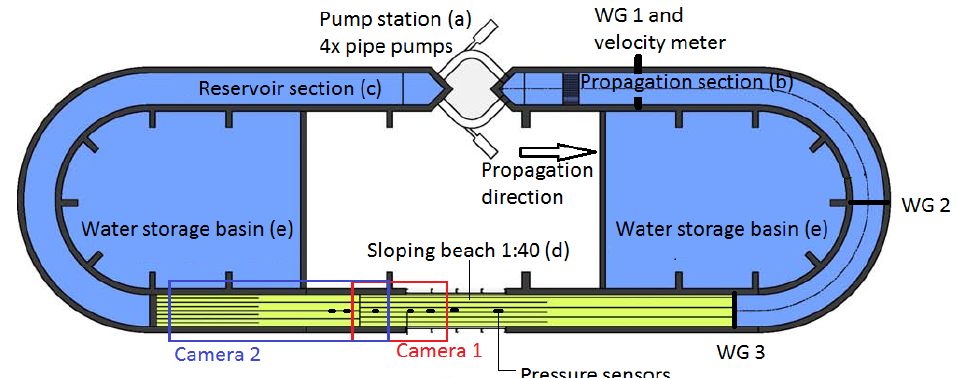
Figure 2. Schematic drawing of the wave flume and its components with position indication of instrumentation. Adapted from [38], with permission from c (cid:13) 2012 World Scientific Publishing Company